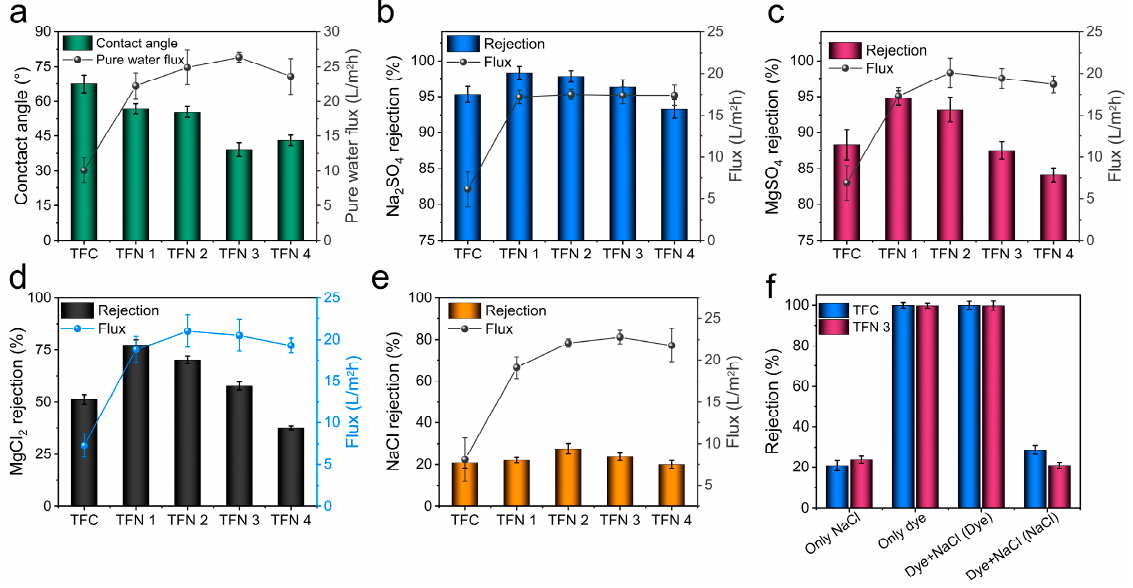
Figure 4. Water contact angle and pure water flux measurements of the fabricated membrane ( a ); Flux and rejection of the fabricated membranes for different salts, Na 2 SO 4 ( b ), MgSO 4 ( c ) MgCl 2 ( d ) , and NaCl ( e ); Dye/salt separation performances of TFC and TFN 3 membranes ( f ).